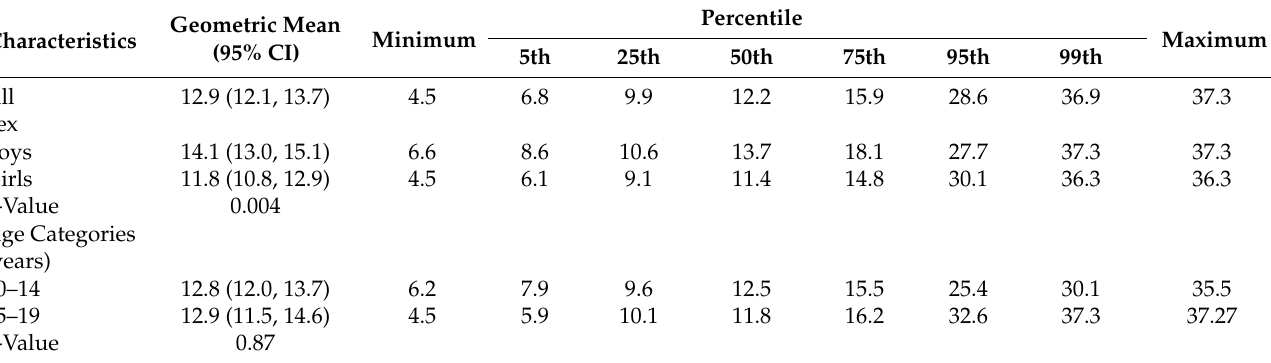
Table 2. Percentile distribution of homocysteine levels by sex and